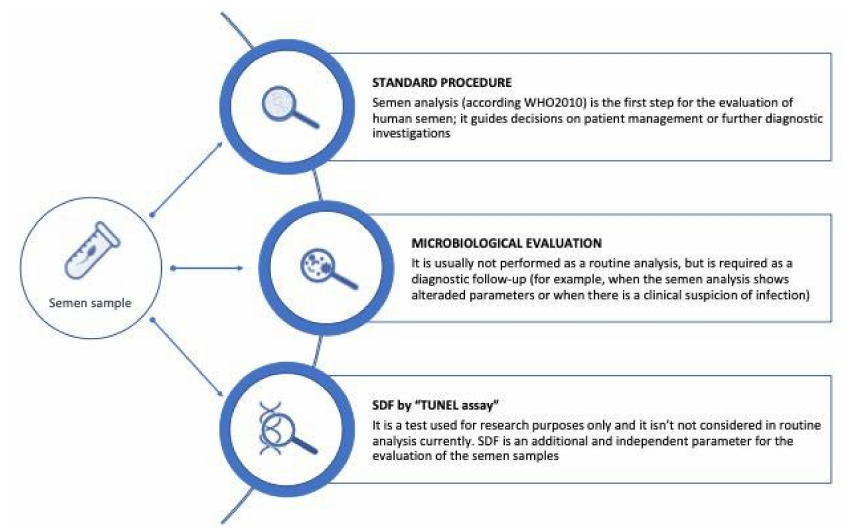
Figure 1. Methods used for the combined assessment of the human semen